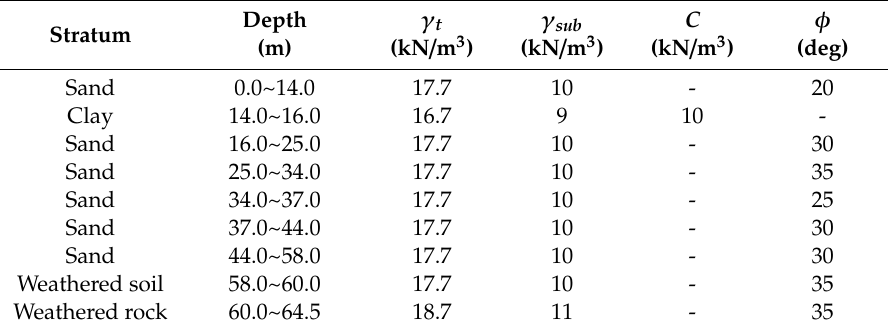
Figure 3. Selected site for the 5-GW wind farm project. Table 2. Soil conditions.